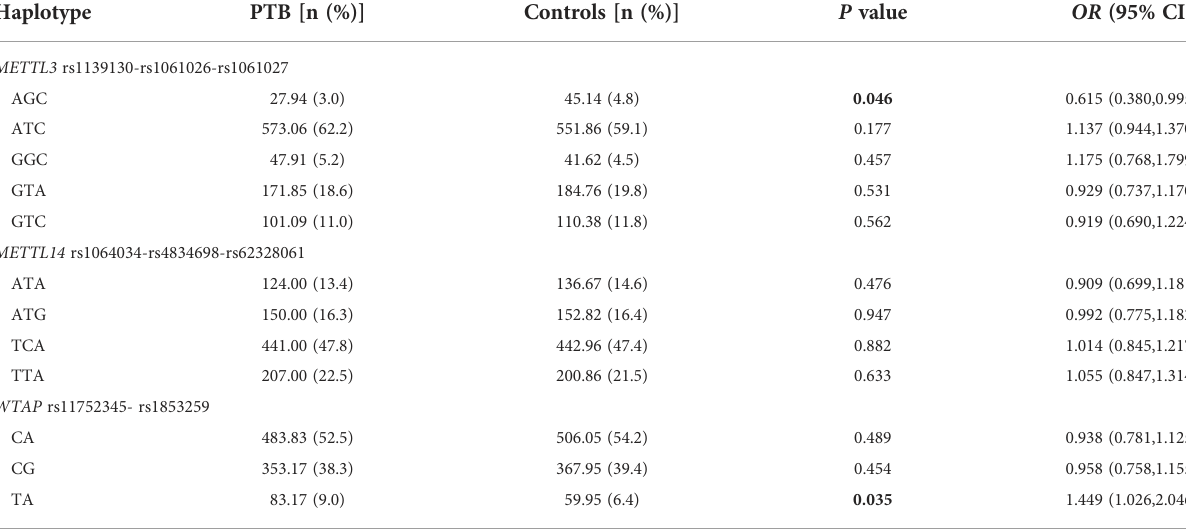
TABLE 3 Haplotype analysis of METTL3 , METTL14 , and WTAP genes in PTB patients and controls.